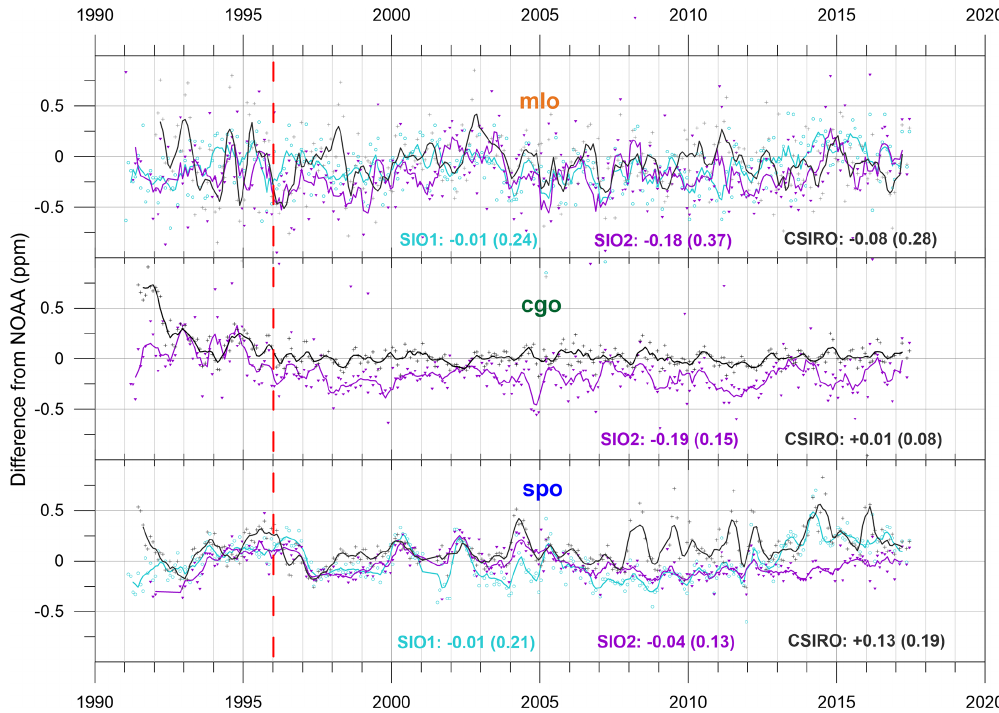
Figure 1. Monthly CO 2 differences (in ppm) from NOAA for sites mlo, cgo, and spo and networks SIO1, SIO2, and CSIRO. Five-month running means are highlighted. 1996–2016 mean and standard deviation (bracketed) values are included.